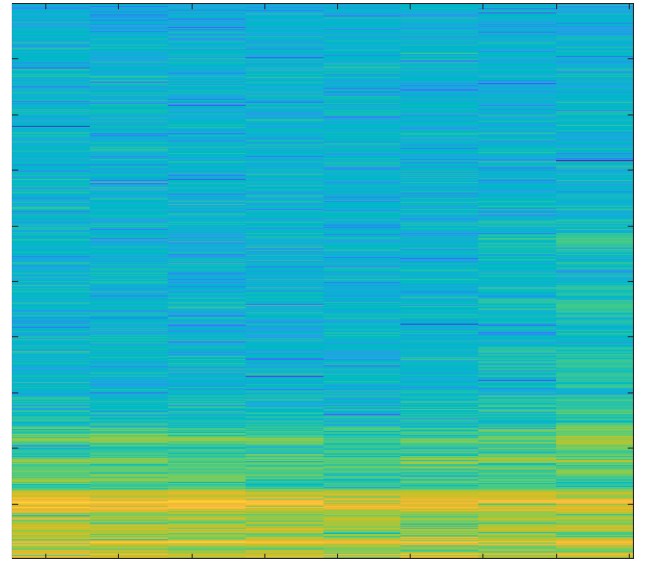
Figure 11. Hardwood, Average Tool, 3 mm depth-of-cut.